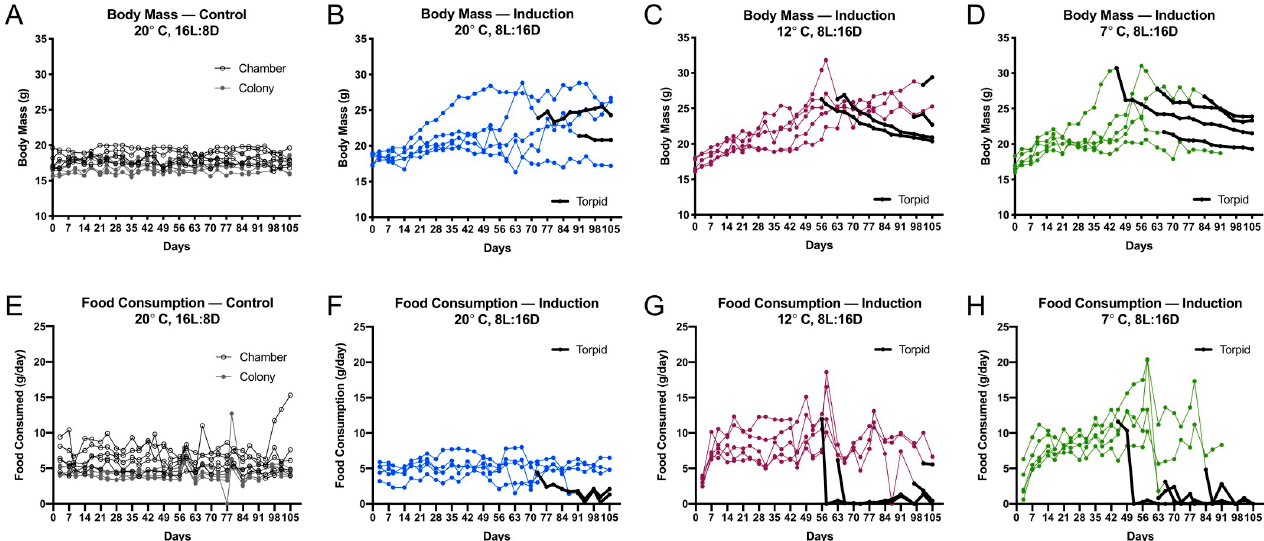
Fig 4. Short photoperiod and low temperature induce hibernation in captive-reared meadow jumping mice. Body mass ( A-D ) and average daily food consumption ( E-H ) are shown for control conditions (16L:8D, 20˚ C) and three hibernation induction conditions. Data are marked black during the period when the corresponding animal was found torpid. ( A ) Body mass of control animals in an environmental chamber (open circles, n = 5), or colony housing room (closed circles, n = 5). ( B ) Body mass at 20˚ C and 8L:16D, n = 5. ( C ) Body mass at 12˚ C and 8L:16D, n = 5. ( D ) Body mass at 7˚ C and 8L:16D, n = 5. ( E ) Average daily food consumption of control animals in an environmental chamber (open circles, n = 5), or colony housing room (closed circles, n = 5). ( F ) Average daily food consumption at 20˚ C and 8L:16D, n = 5. ( G ) Average daily food consumption at 12˚ C and 8L:16D, n = 5. ( H ) Average daily food consumption at 7˚ C and 8L:16D, n =